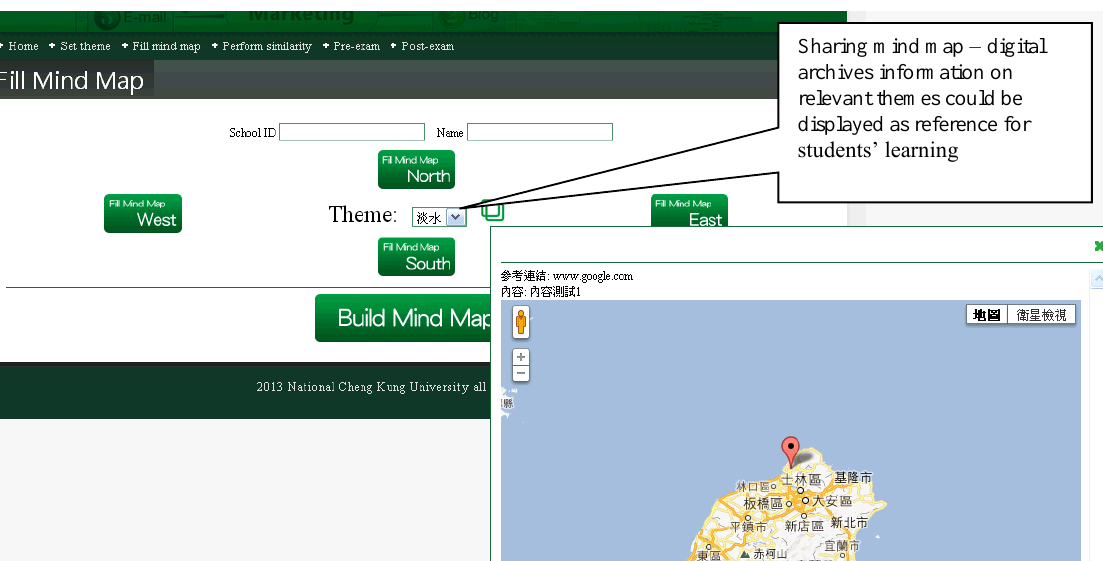
Figure 4. Digital archive map –